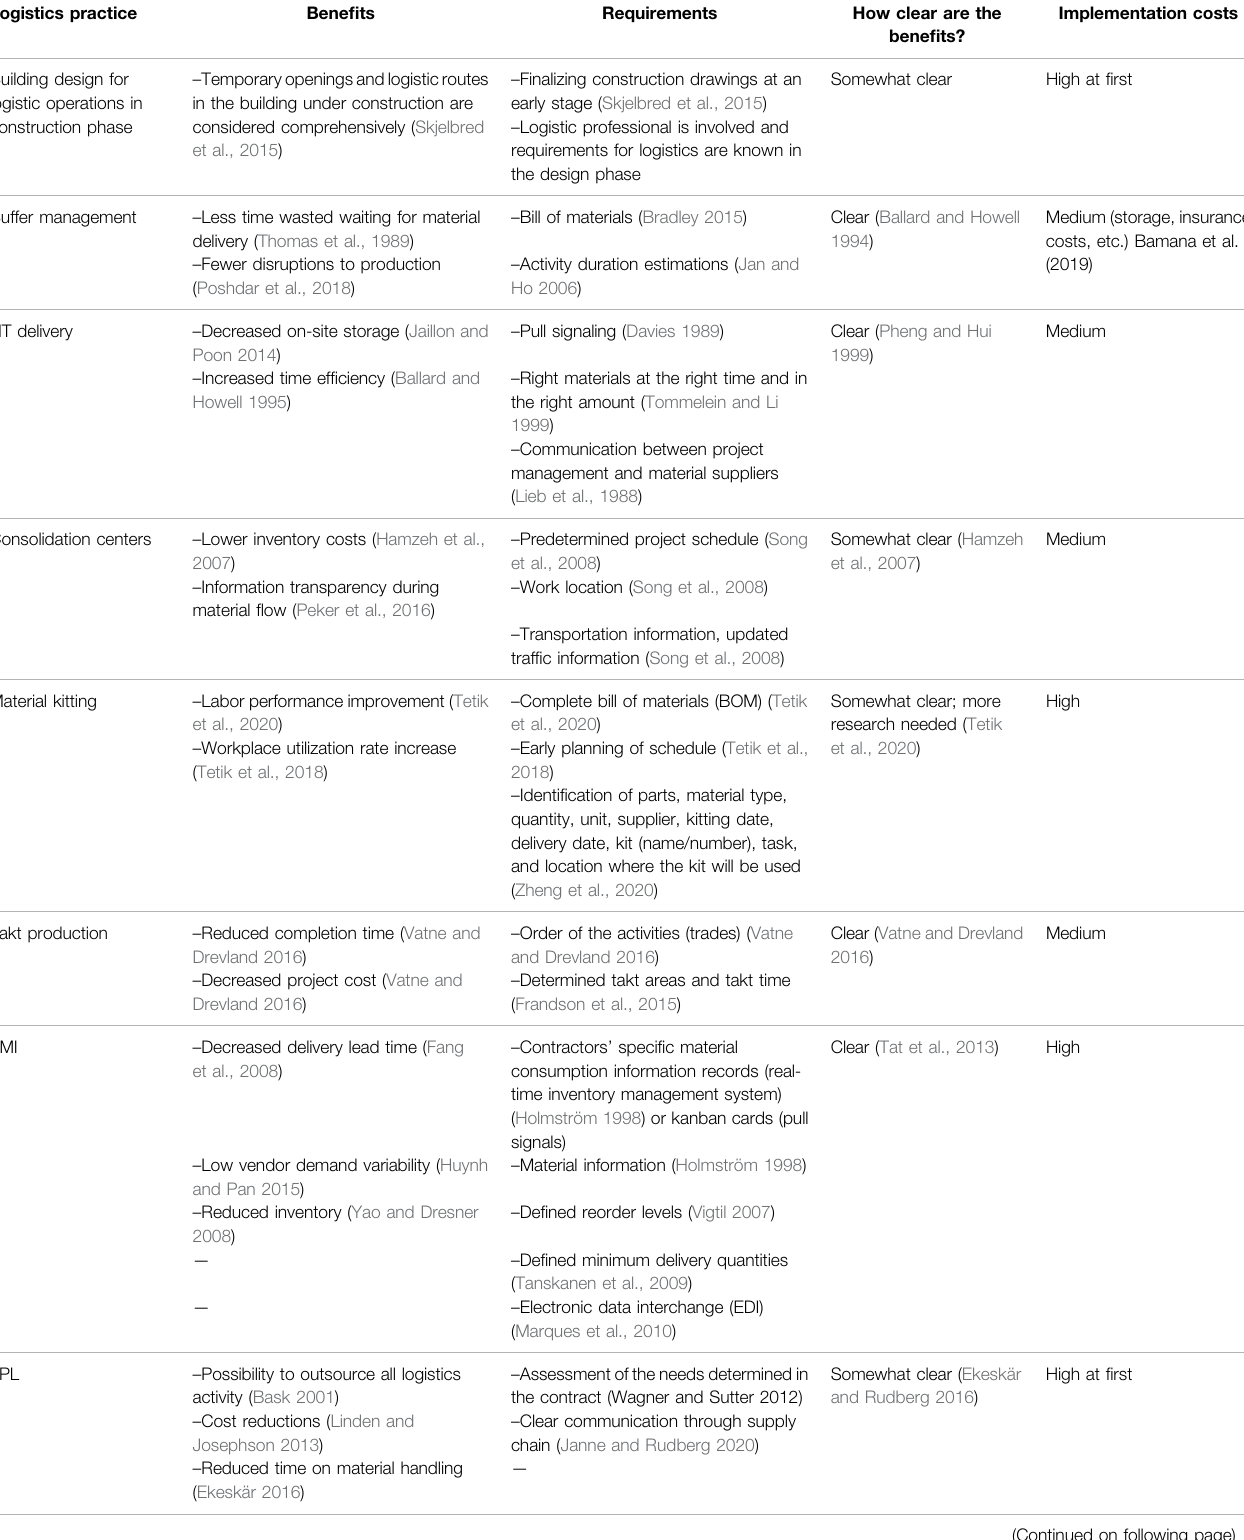
TABLE 1 | Logistic practices used in construction, including their requirements and bene fi